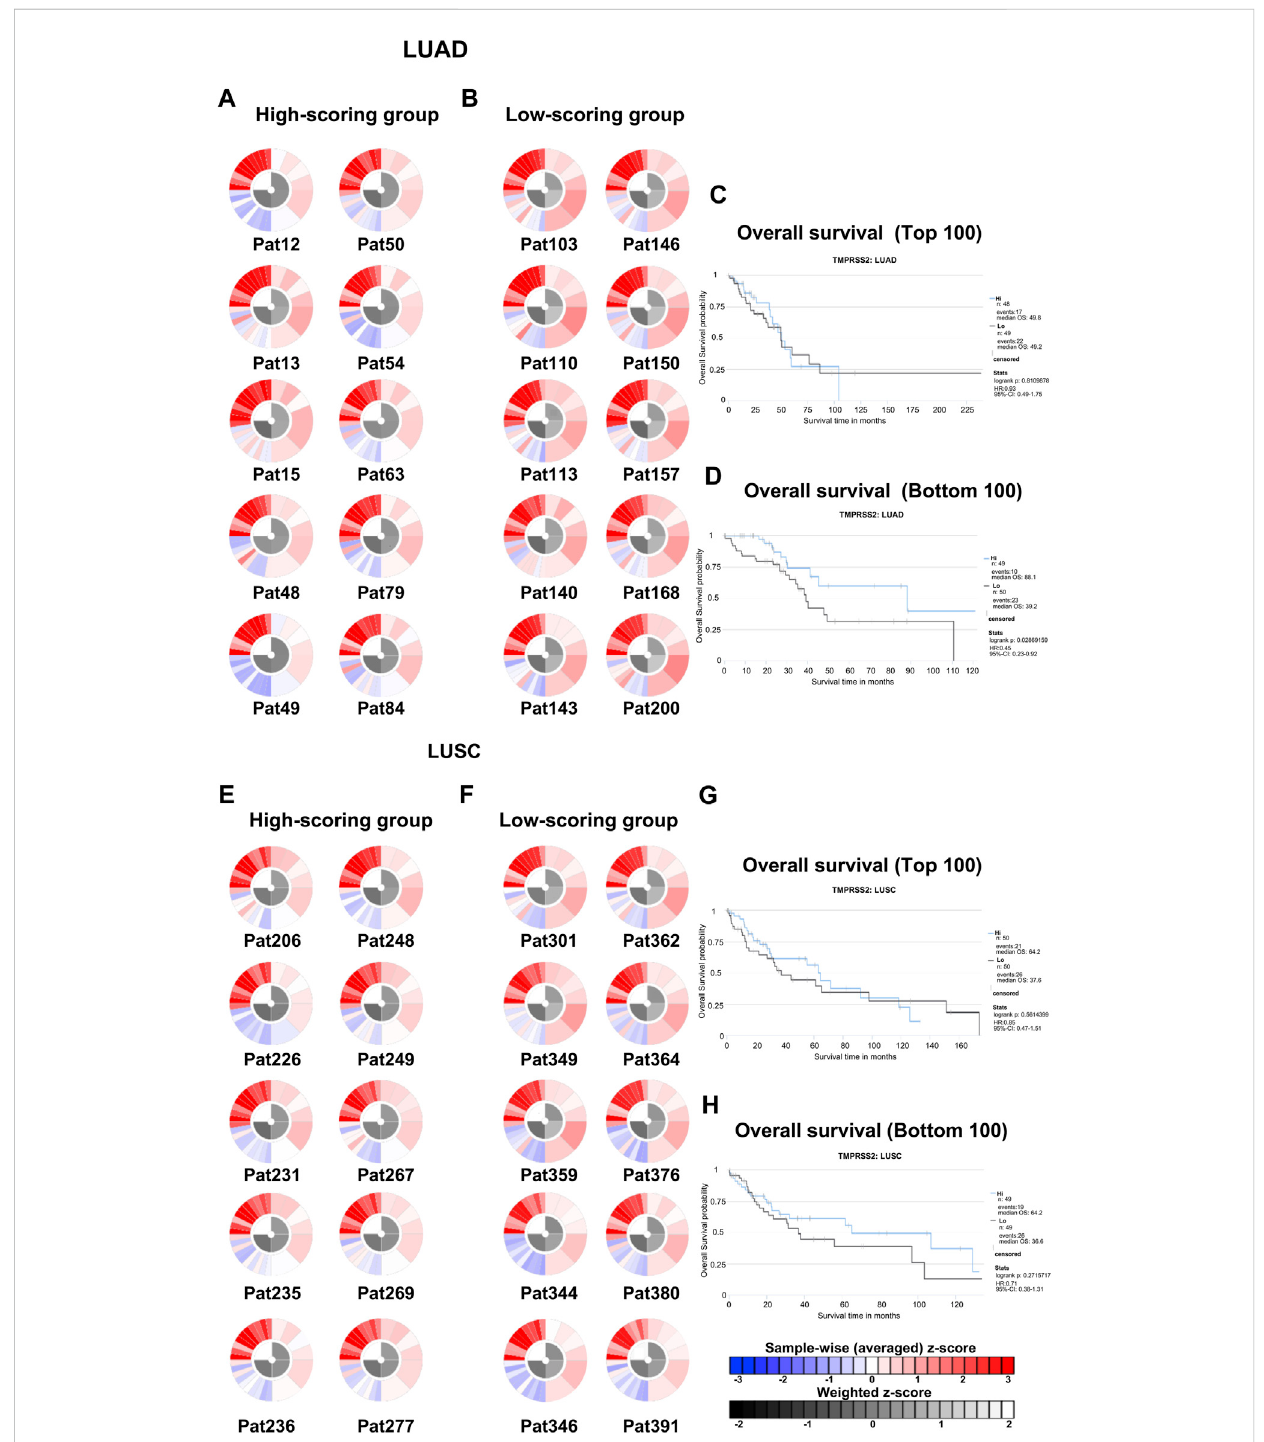
FIGURE 8 Immunophenoscores and overall survival of patients with lung cancer that response to PD-1 blockers immunotherapy in TCIA. (A) Immunophenograms for individual patients in the top 100 IPS_PD-1_pos patients with LUAD, The wheel contains individual factors were classi fi ed into four categories (clockwise direction), effector cells (EC), suppressor cells (SC), immunomodulators (CP), and MHC molecules (MHC). Effector cells including activated CD4 + T cells, activated CD8 + T cells, effector memory CD4 + T cells, effector memory CD8 + T cells. Immunosuppressive cells including MDSC and Treg. Immunecheckpoint markers include LAG3, PDCD1, CTLA4, TIGIT, PDCD1LG2, HAVCR2, CD274, IDO1, CD27, ICOS,and B2M. MHCmoleculesincludingTAP1,TAP2,HLA-A,HLA-B,HLA-C,HLA-DPA1,HLA-DPB1,HLA-E,andHLA-Fintheclockwisedirection.Thedatadisplayedby the weighted average z-scores for the elements within the particular category (z > 0; showed in red, z < 0; showed in blue) (B) Immunophenograms for individual patients in the bottom 100 IPS_PD-1_pos patients with LUAD. (C) Overall survival of the top 100 IPS_PD-1_pos patients with LUAD. (D) Overall survival of the bottom 100 IPS_PD-1_pos patients with LUAD. (E) Immunophenograms for individual patients in the top 100 IPS_PD-1_pos patients with LUSC. (F) Immunophenograms for individual patients in the bottom 100 IPS_PD-1_pos patients with LUSC. (G) Overall survival of the top 100 IPS_PD-1_ pos patients with LUSC. (D) Overall survival of the bottom 100 IPS_PD-1_pos patients with